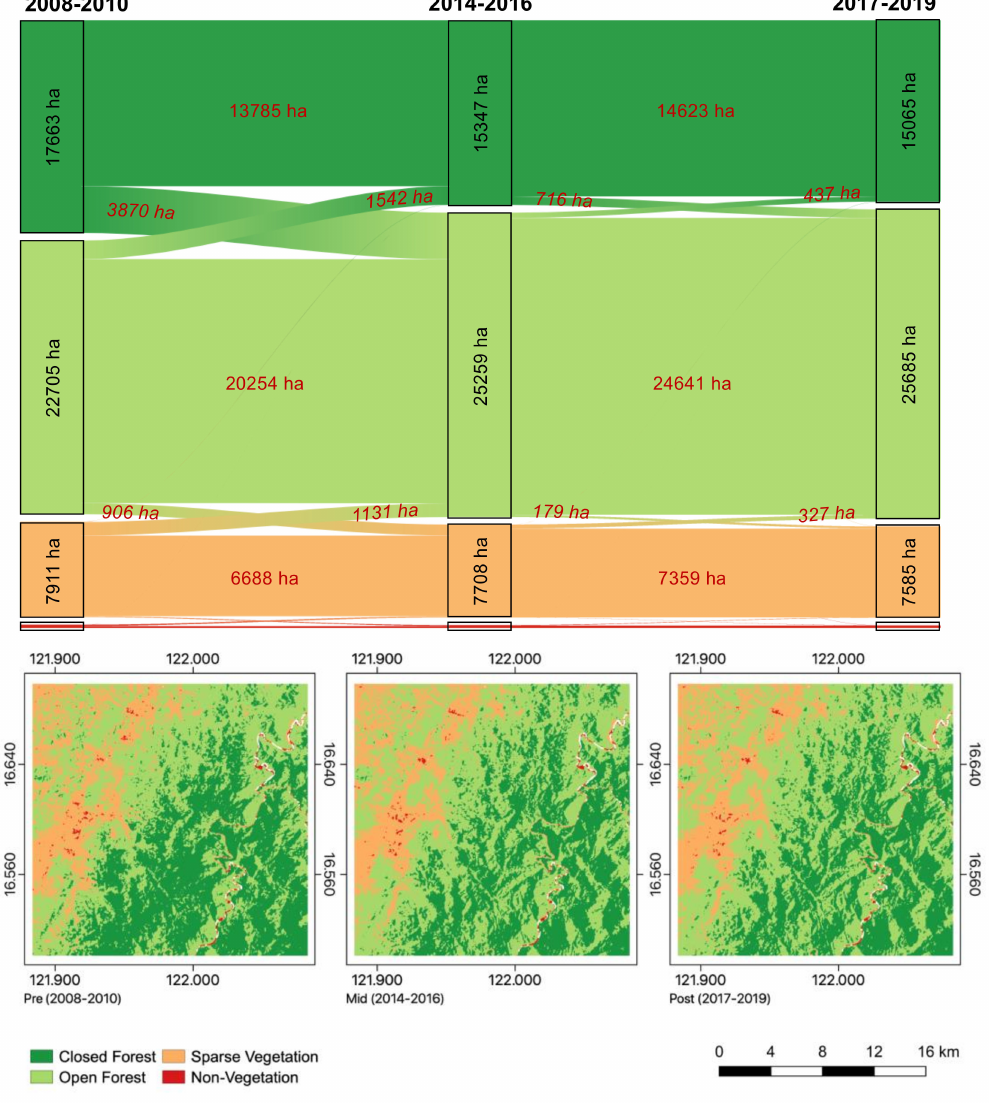
Figure 8. Classified Landsat images in Site 2 before (2008–2010), during (2014–2016), and after (2017–2019) NGP, and associated Sankey